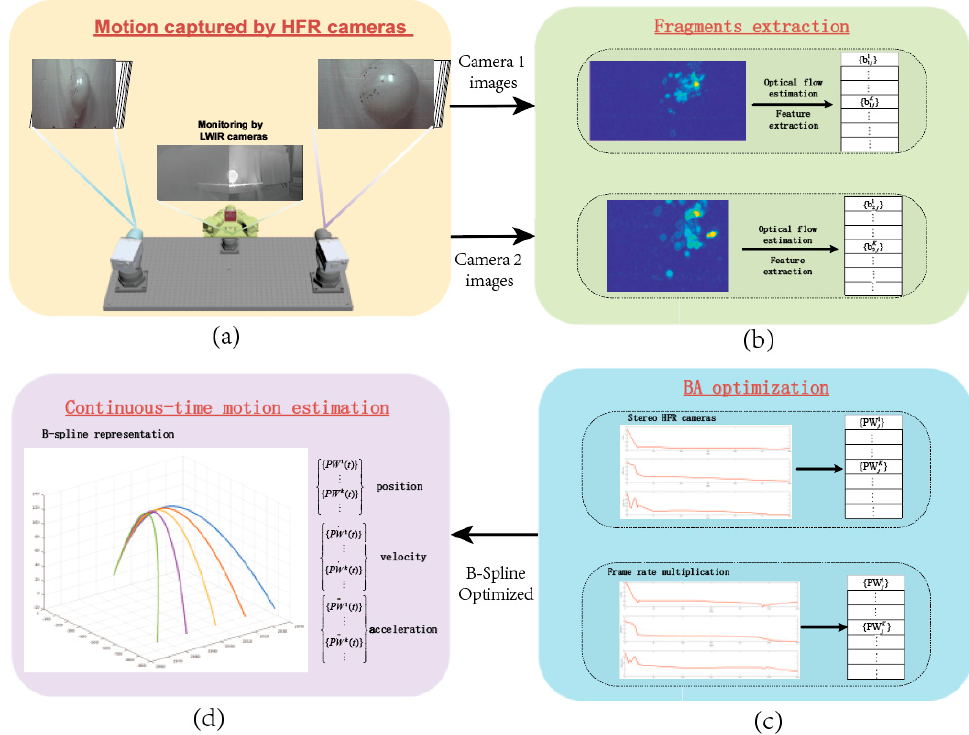
Figure 6. Procedure of our method. ( a ) Motion captured by HFR cameras; ( b ) Fragments extraction; ( c ) Bundle adjustment optimization; ( d ) Continuous ‐ time motion estimation